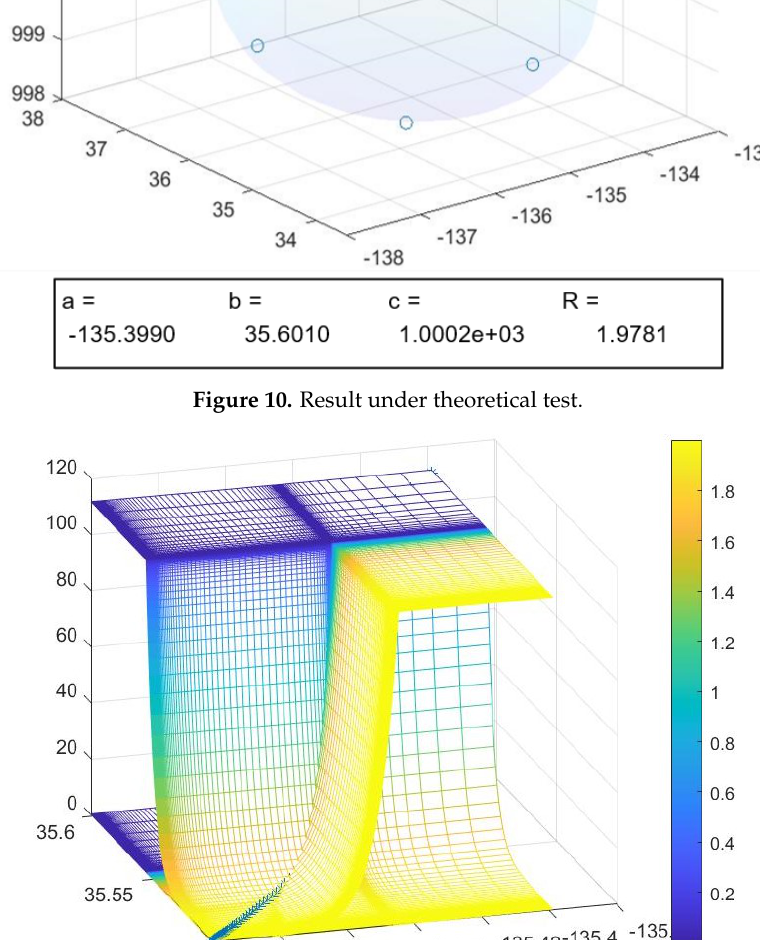
Figure 11. Heat map of cost